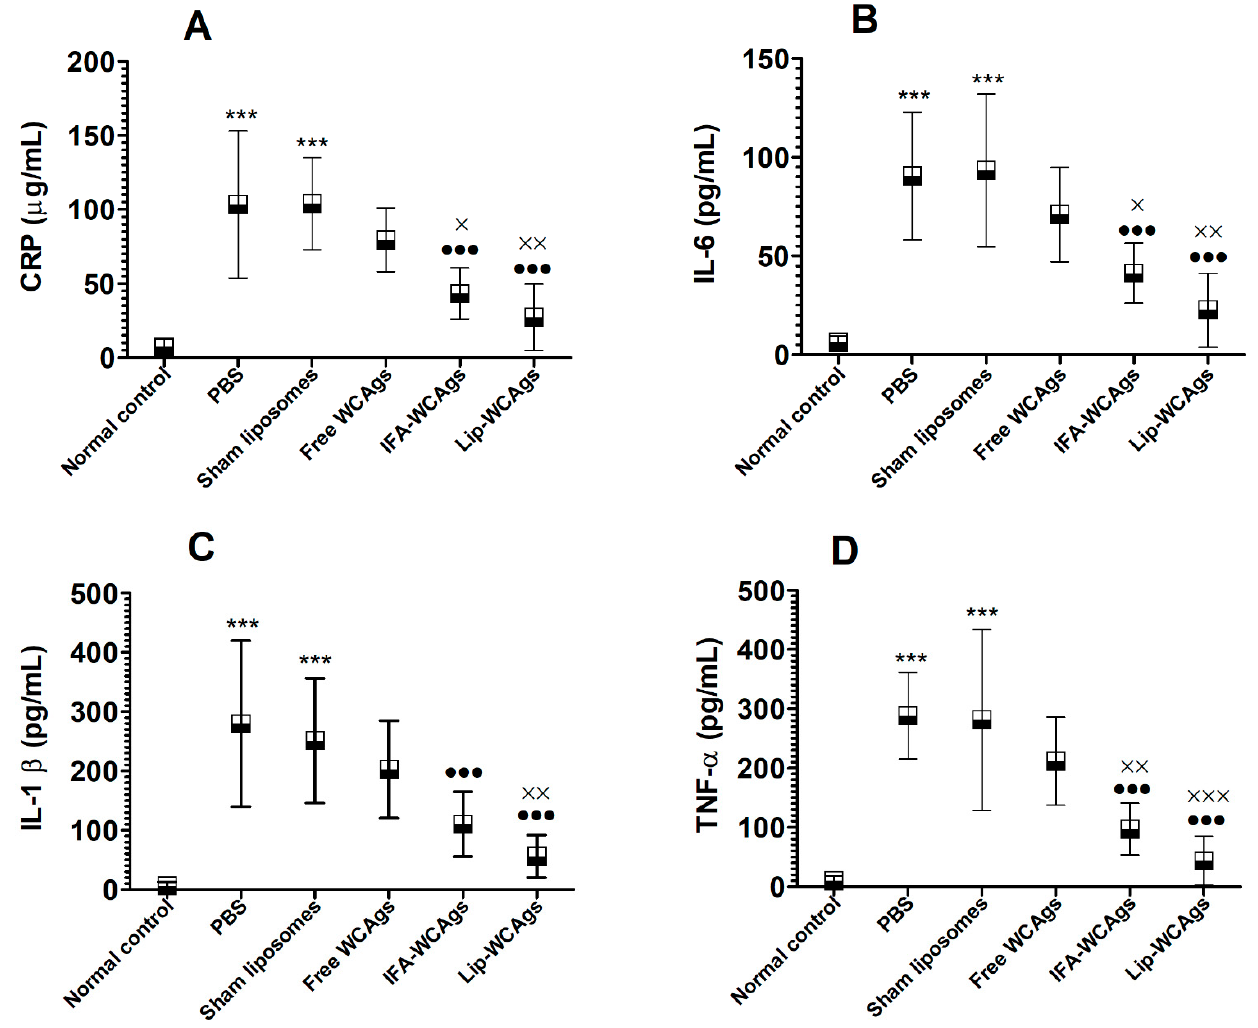
Figure 8. Lip-WCAgs-immunized mice showed the lowest level of CRP, IL-6, IL-1 β and TNF- α in the systemic circulation. ( A ) CRP. *** ( p < 0.001) normal control vs. PBS or Sham liposomes, ( p < 0.001) PBS vs. IFA-WCAgs or Lip-WCAgs, × ( p < 0.05) Free WCAgs vs. IFA-WCAgs, ×× ( p < 0.01) Free